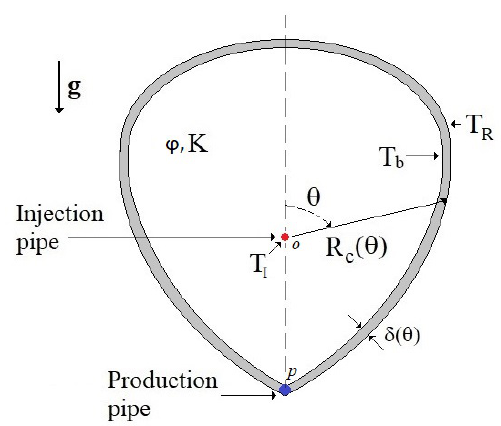
Figure 1. Schematic of the cross-section of the steam chamber at a certain point in time. It has a symmetrical shape, r = R c ( θ ) , where θ is measured clockwise from the upper vertical axis ( θ = 0). The steam chamber is a porous medium of porosity ϕ and permeability K , and we assume that the main flow is due to the steam spreading to the chamber edge, where it condensates in the layer δ ( θ )